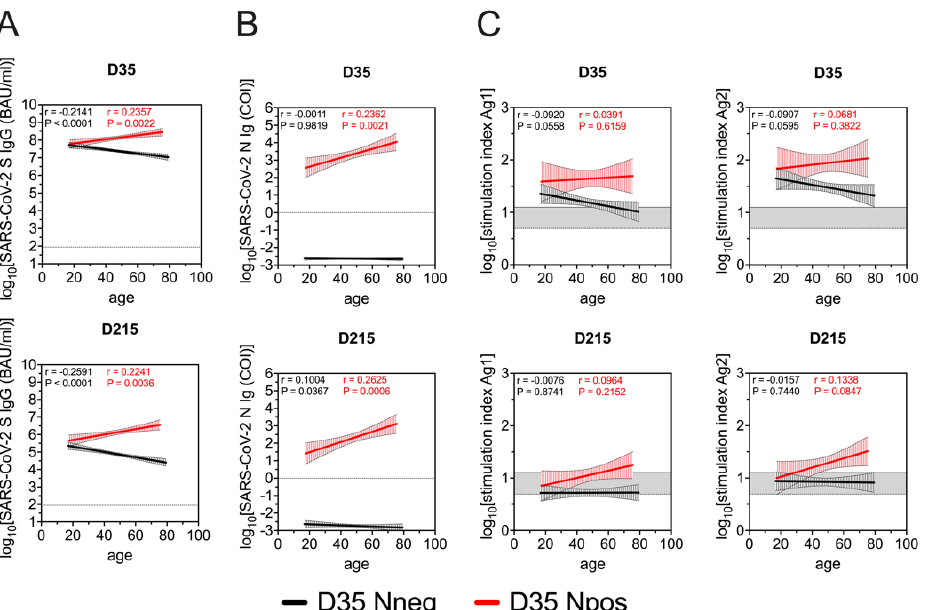
Figure 3. Correlation between age and SARS-CoV-2-specific S IgG ( A ), N Ig ( B ) and T cell ( C ) responses after BNT162b2 vaccination in groups with no (D35 Nneg, black) and prior SARS-CoV-2 infection (D35 Npos, red). Pearson correlation coefficients were calculated for log10-transformed values of immunological parameters at different time points and age at baseline separately for individuals with and without prior SARS-CoV-2 infection.